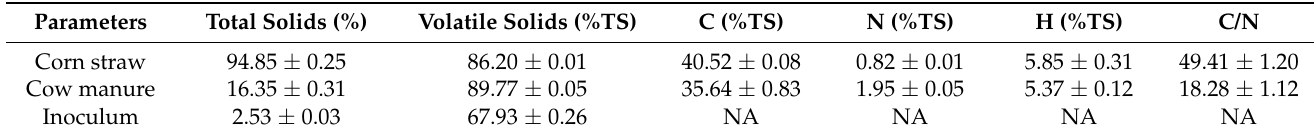
Table 1. Characteristics of the corn straw, cow manure and